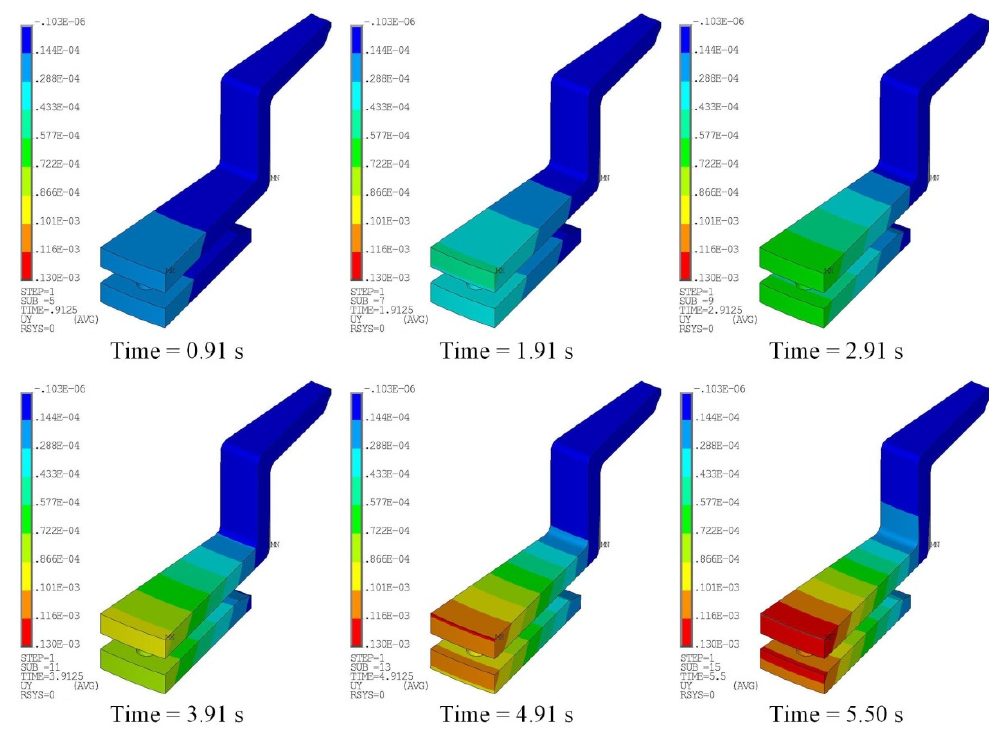
Figure 15. Deformations in y-direction of the sliced baseline model.